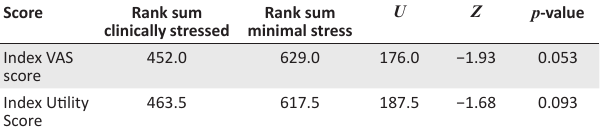
TABLE 6: The association between Visual Analogue Scale (VAS) and the EQ-5D Utility Index Scores of those who were clinically stressed ( N = 23) and those who were not ( N = 23).